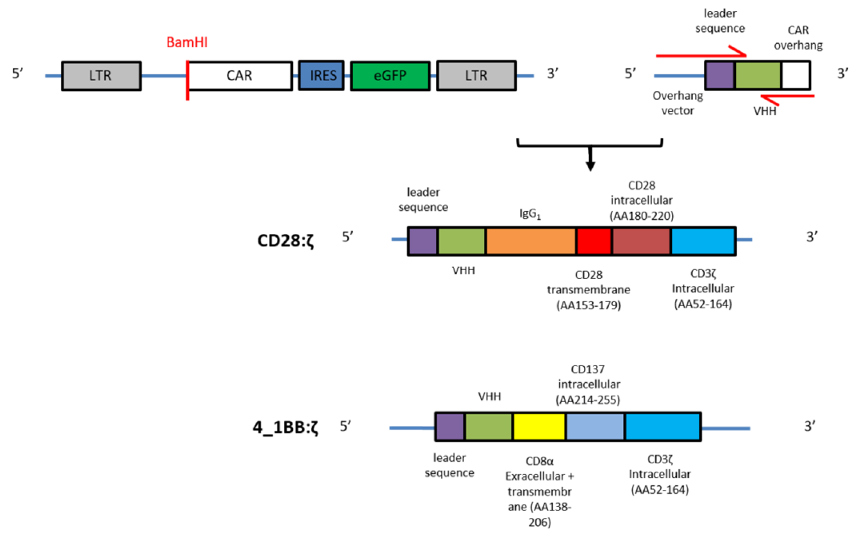
Figure 1. Generation of the nanoCAR constructs: schematic representation of the retroviral CAR backbone plasmid, nanobody with leader sequence and overhangs at 5′ and 3′, and the two different nanoCAR constructs. Red arrows indicate forward and reverse primers.